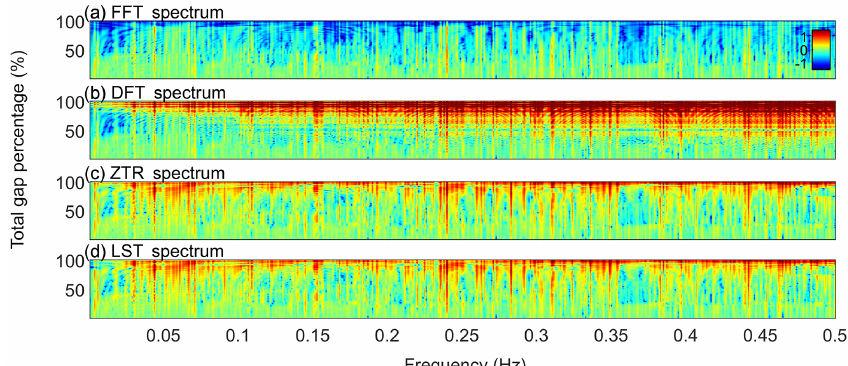
Figure 14. SLG test applied to the VEX data set. Represented are the difference of amplitude spectra (method – original) as a function of TGP and frequency for: (a) FFT, (b) DFT, (c) ZTR and (d) LST.